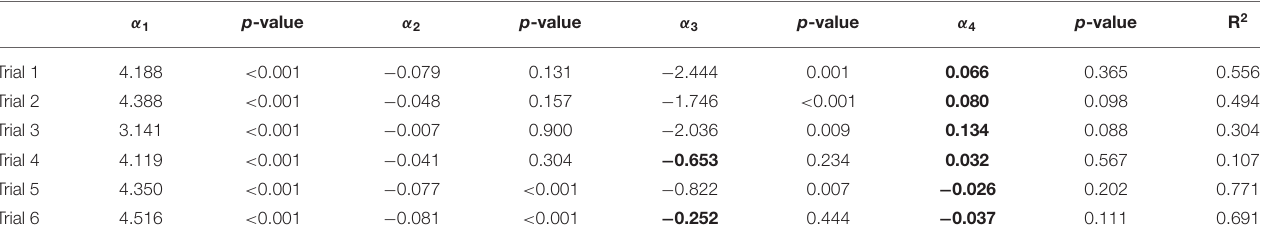
TABLE 4 | Statistical and estimated coefficients for model to evaluate the longevity and comparisons of E. coli survival in effluent by use of ZVI-sand and sand for trials